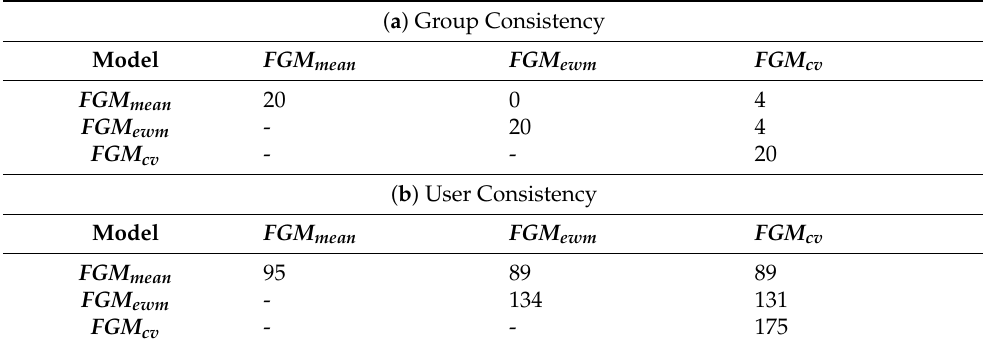
Table 5. Results